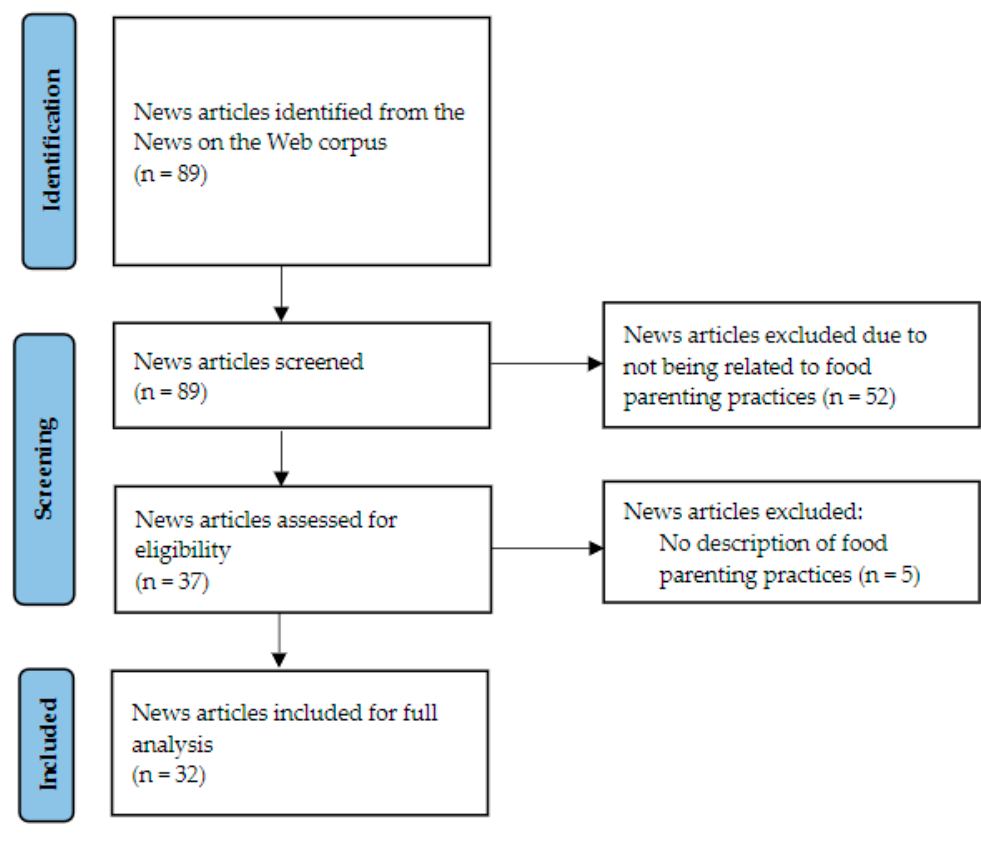
Figure 1. News article flow chart. Table 2. Articles ( n = 32) by newspaper genre and publication